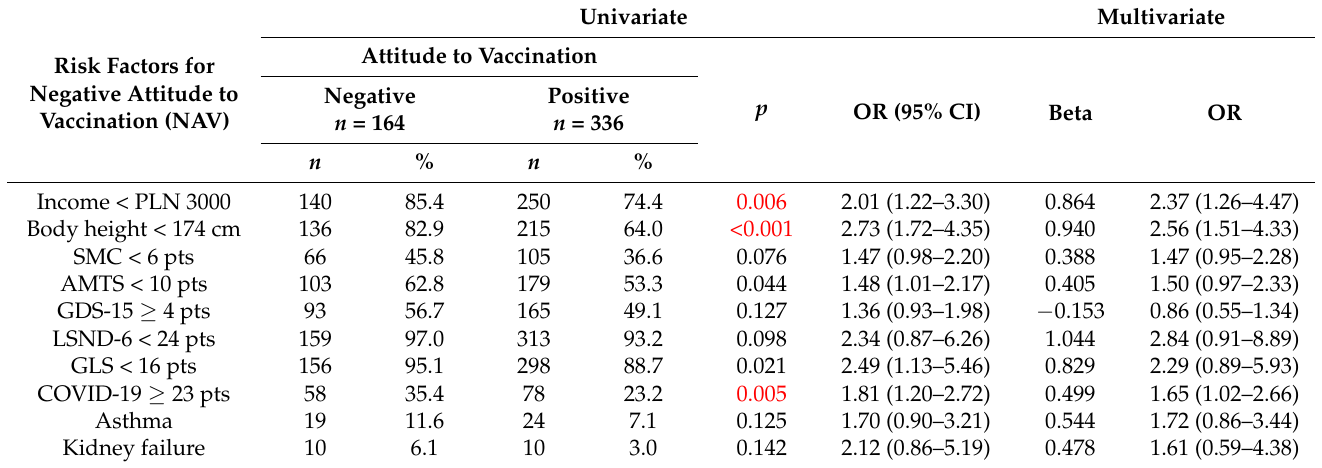
Table 2. Results of logistic regression of univariate and multivariate sociodemographic, clinical and psychological parameters of negative attitude toward